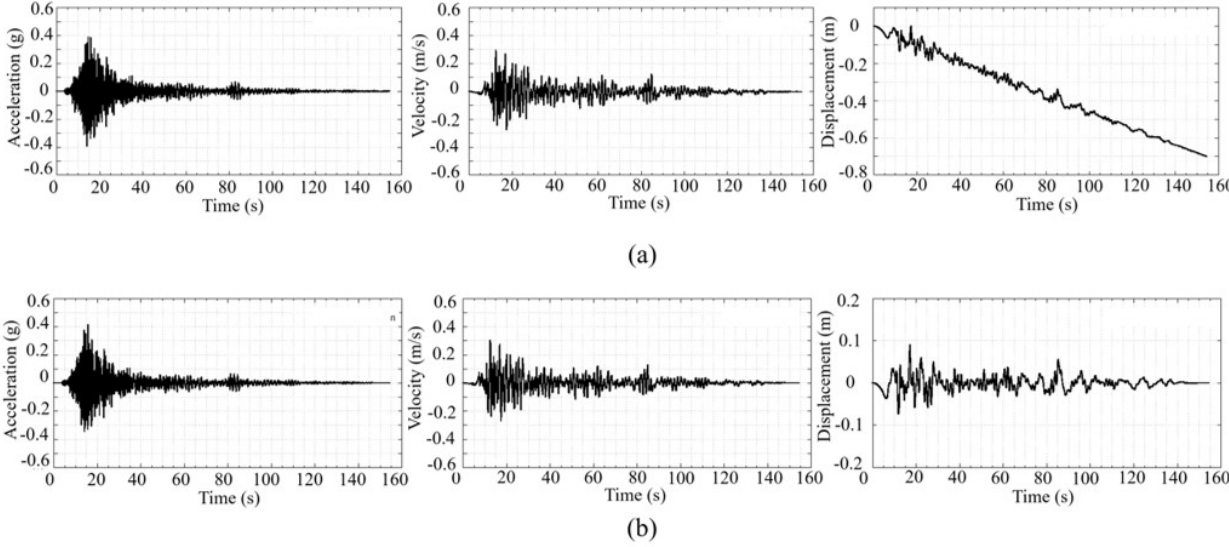
Figure 10. Acceleration, velocity and displacement time histories (a) without baseline correction and (b) with baseline